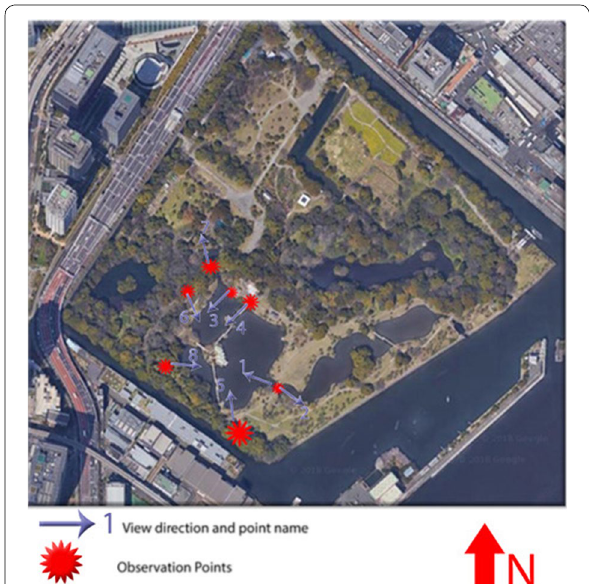
Fig. 1 The location of the study area (Source: Google Maps. September 18,